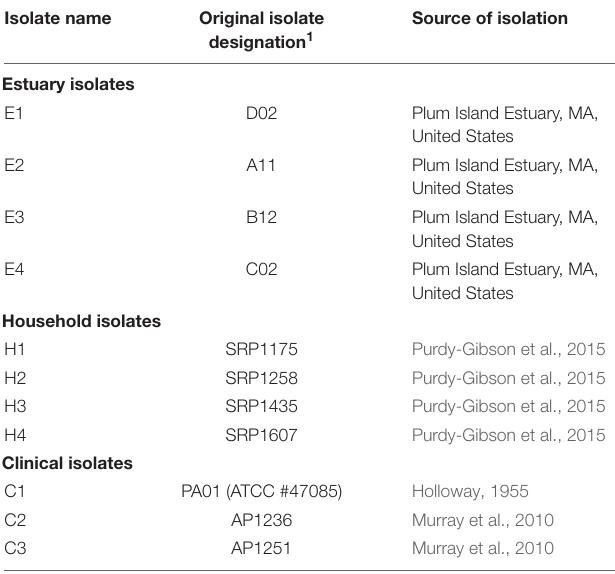
TABLE 1 | Bacteria designations by isolation